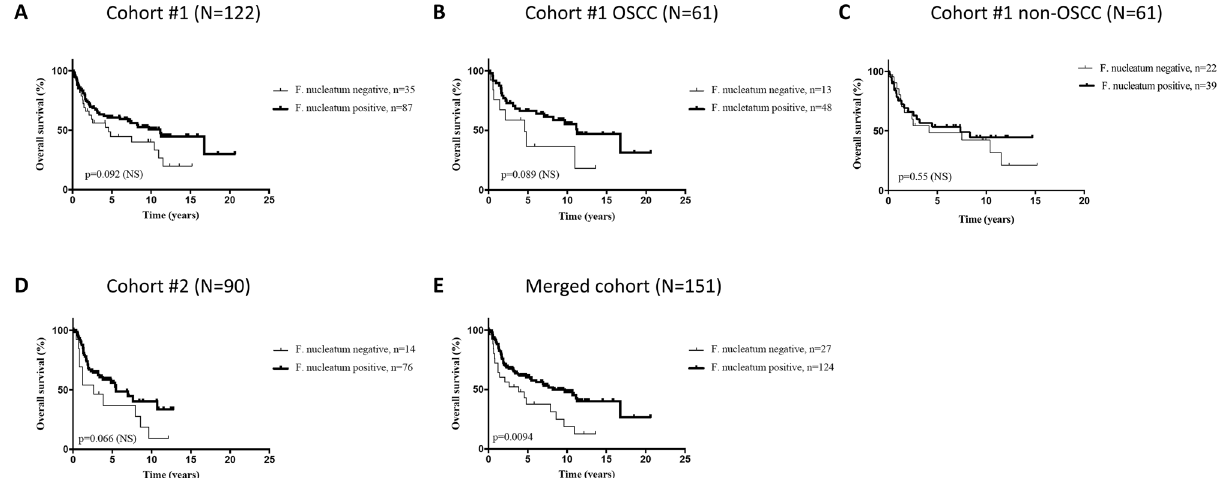
Figure 2. Overall survival (OS) curves according to F. nucleatum status ( A ) in the overall head and neck squamous cell carcinoma (HNSCC) patient population (N = 122), ( B ) in the oral cavity tumor (OSCC) subgroup (N = 61) of cohort #1, ( C ) in the non-OSCC subgroup (N = 61) of cohort #1, ( D ) in cohort #2 (N = 90), and ( E ) in the merged cohort (N =